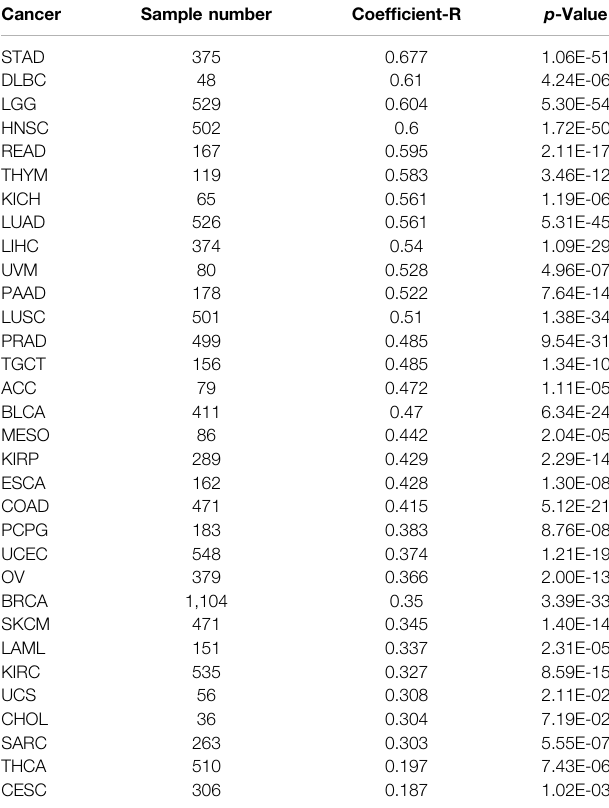
TABLE 3 | The correlation between the PTBP1 and IQGAP3 expressions. Cancer Sample